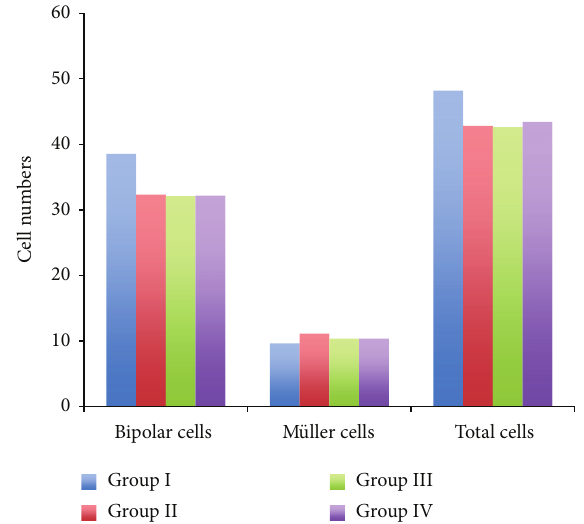
Figure 4: The comparison of Bipolar and M¨uller cells number among all groups. The cross-section of the retinas was prepared and examined under the microscope for histological